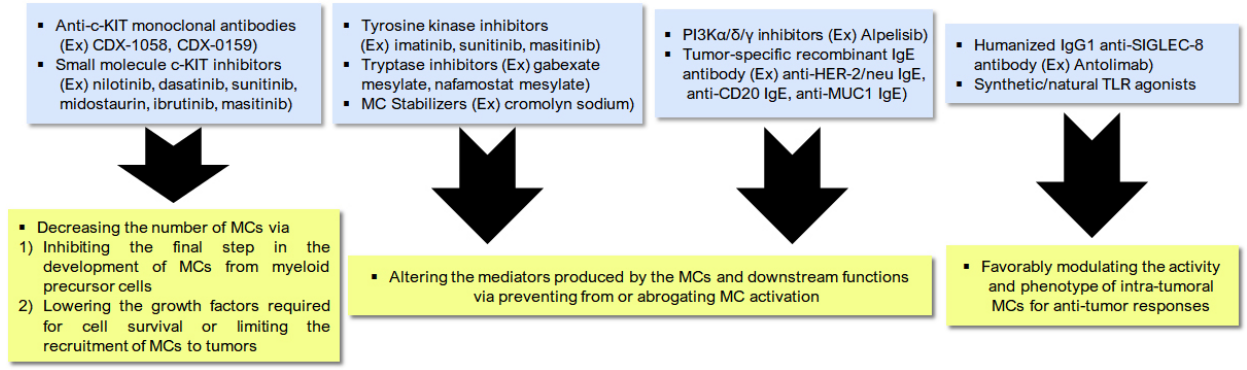
Figure 3. Potential therapeutic strategies targeting tumor-infiltrating MCs to promote anti-tumor